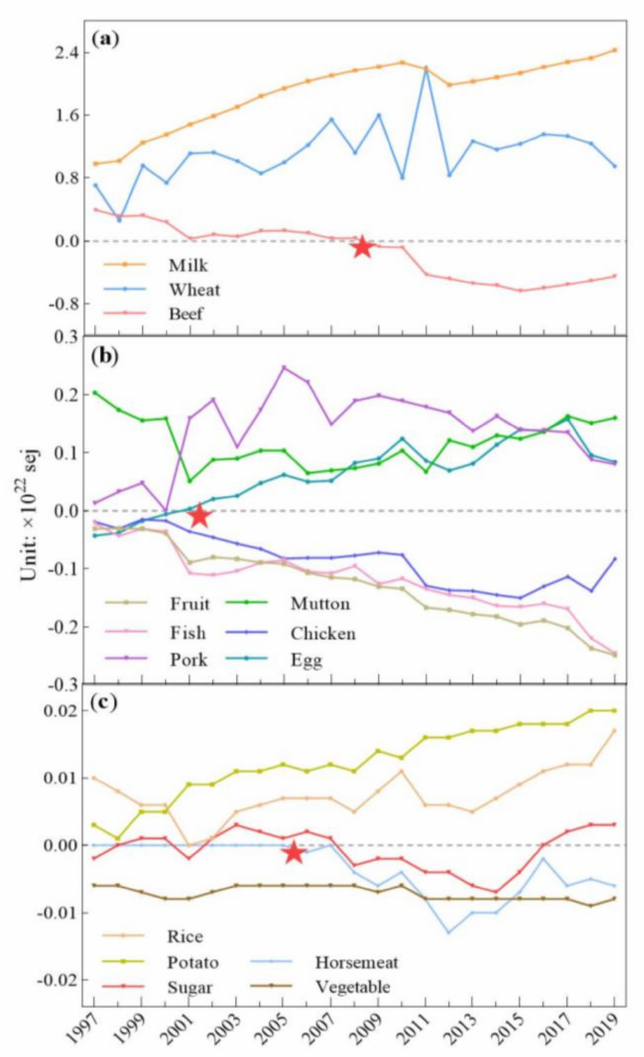
Figure 6. Annual food gap between local production and consumption in Kazakhstan. ( (cid:70) represents the turning point). ( a ) annual local production and consumption gap of milk, beef and wheat; ( b ) annual local production and consumption gap of fruit, fish, pork, mutton, chicken and egg; ( c ) annual local production and consumption gap of rice, potato, sugar, horsemeat and